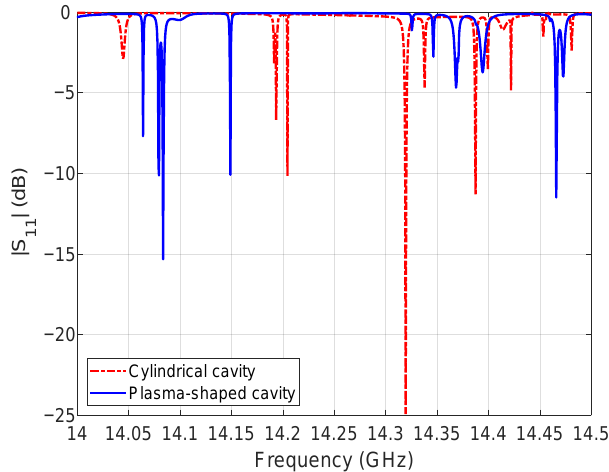
Figure 9. | S 11 | curve, for the standard cylindrical cavity and the “plasma-shaped” one with the slotted waveguide microwave injection system, inside the operational bandwidth of 14–14.5